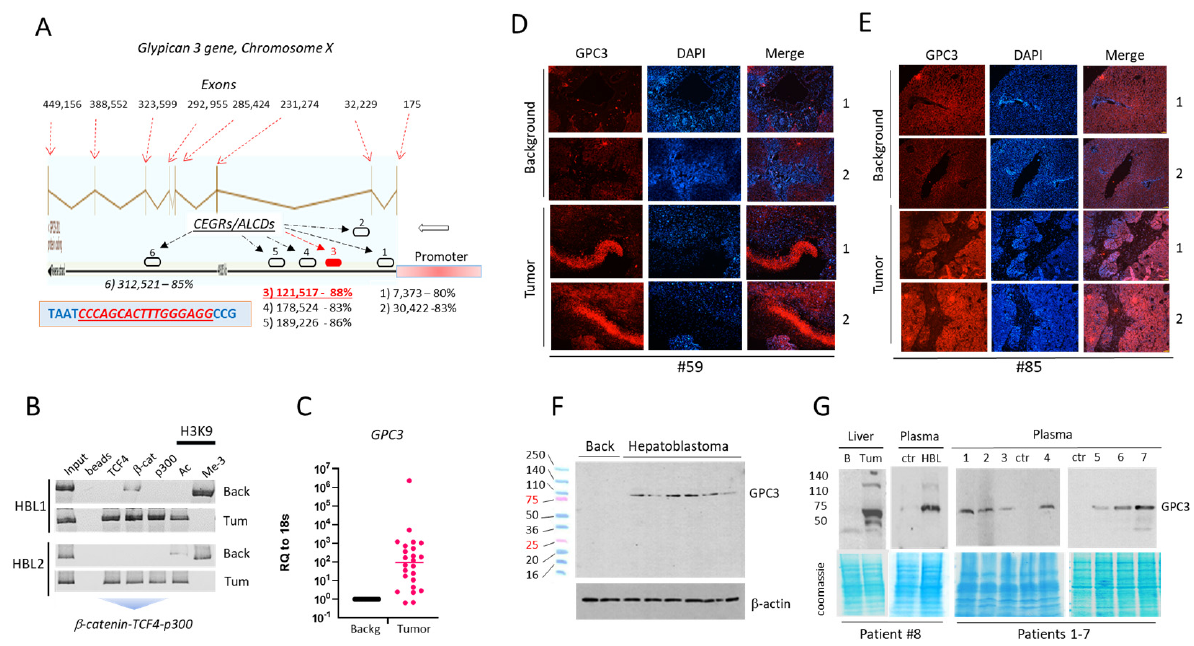
Figure 3. GPC3 is elevated in HBL patients by β -catenin-TCF4-p300 pathway via CEGRs/ALCDs in GPC3 gene. ( A ) Structure of the GPC3 gene. The 100% homologous TCF4 binding site is shown in the blue box. ( B ) ChIP assay with the third CEGR/ALCD of GPC3 . ( C ) GPC3 mRNA expression in a fresh biobank of HBL samples ( n = 32) ( p = 0.3202, unpaired t -test). ( D , E ) IF staining of pediatric liver cancer sections with antibodies to GPC3. ( F ) GPC3 expression in specimens from a fresh biobank was determined by Western blot. ( G ) Levels of GPC3 in blood of eight HBL patients with active ph-S675- β -catenin-TCF4-CEGRs/ALCDs-GPC3 pathway in liver tumors. The uncropped Western blots have been shown in Figure S9.